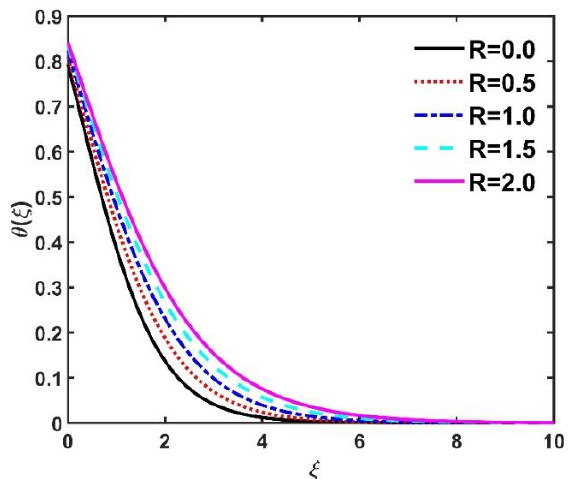
Figure 22. Impact of 𝑅 on 𝜃(𝜉) . Figure 22. Impact of R on θ ( ξ ) Figure 22. Impact of 𝑅 on 𝜃(𝜉) .